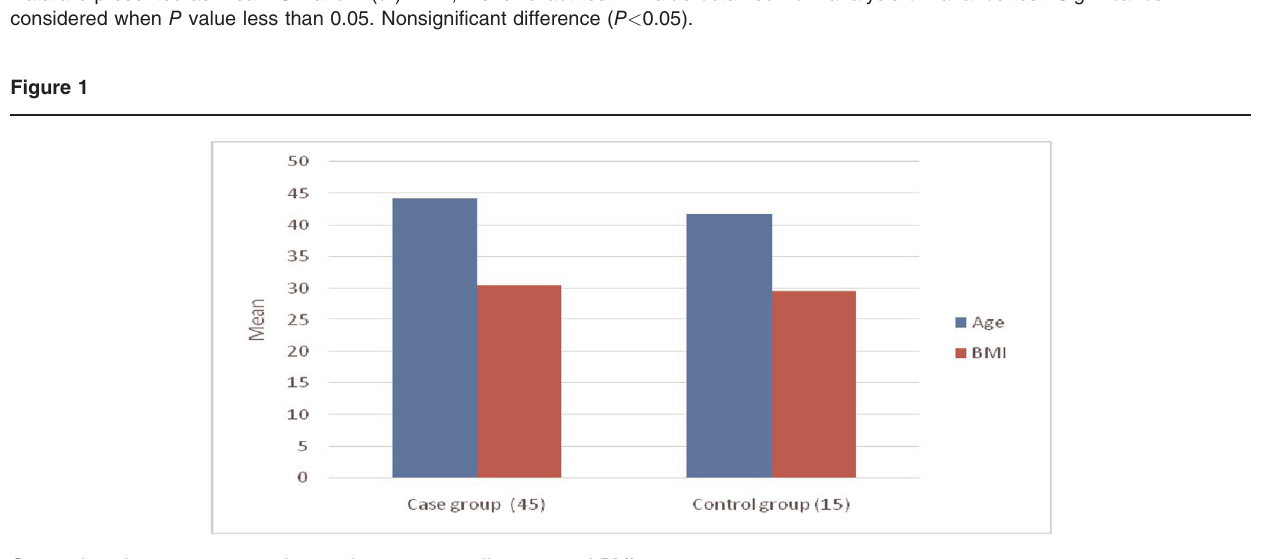
Comparison between case and control groups regarding age and BMI.